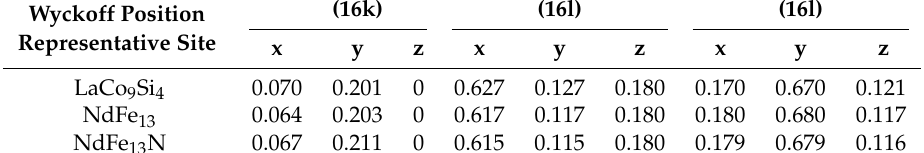
Table 1. Experimental internal structural parameters of LaCo 9 Si 4 taken from Michor et al. [12] are compared to the structural parameters of NdFe 13 and NdFe 13 N, which were obtained by density functional theory (DFT) optimization of the lattice parameters a and c as well as all the internal coordinates. Wyckoff positions (4a) and (4d) are equal for all structures and given by (0, 0, 1/4) and (0, 1/2, 0), respectively. The interstitial N atoms in NdFe 13 N are located at Wyckoff positions (4c) represented by (0, 0, 1/2).